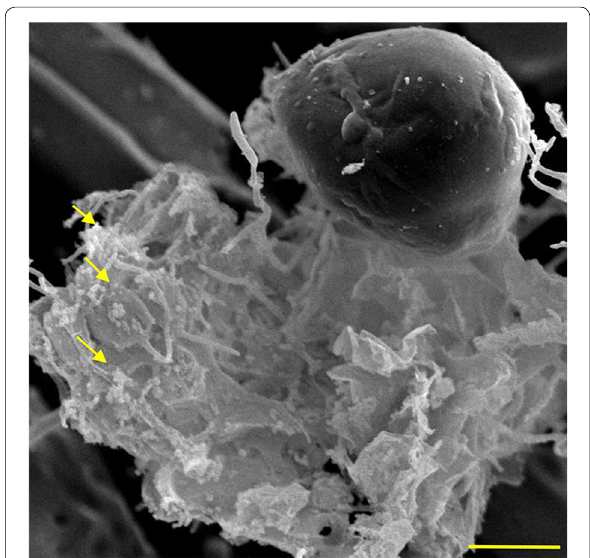
Fig. 1 Scanning electron micrograph of the ( Piromyces ruminantium ) Yak‑G18 co‑culture grown on wheat straw. Arrow, M. ruminantium ; bar 10 μm